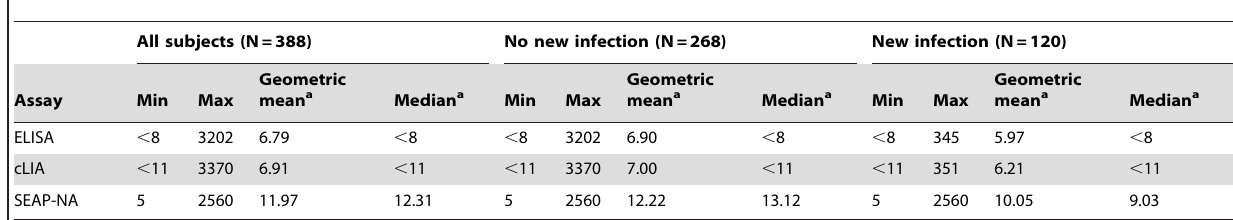
Table 1. HPV16 serology results by incident HPV16 DNA infection status for the 388 subjects selected for assay measurement.